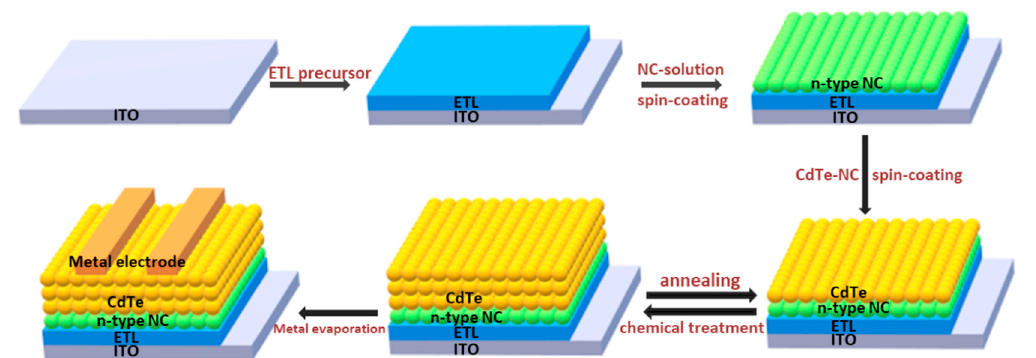
Figure 1. NC solar cells with inverted structure fabricated by a layer by layer solution process.